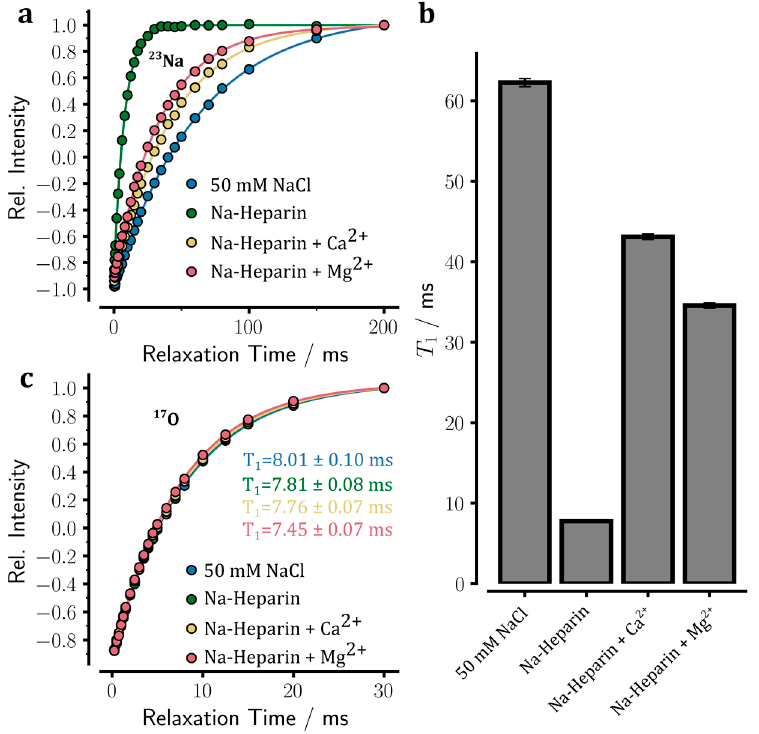
Figure 4. Longitudinal spin-lattice ( T 1 ) relaxation of 23 Na NMR signals in sodium heparin samples determined through standard inversion-recovery NMR experiments. ( a ) The 23 Na inversion-recovery data are shown as relative intensity versus relaxation time (duration of relaxation delay) for the following samples: sodium heparin sample without added ion, sodium heparin samples with 100 mM CaCl 2 or MgCl 2 added, and a reference NaCl solution. Upon the addition of Mg 2+ and especially Ca 2+ ions, the relaxation-induced recovery of 23 Na signals becomes slower and approaches but does not reach, that of the reference NaCl sample. ( b ) The obtained 23 Na T 1 relaxation times of the measured samples. The 23 Na T 1 data show partial Ca 2+ or Mg 2+ ion-dependent release of sodium ions from heparin, which is stronger in the case of Ca 2+ ions. ( c ) The 17 O inversion-recovery data of the above samples show only slight differences in the viscosity-dependent 17 O T 1 of water.